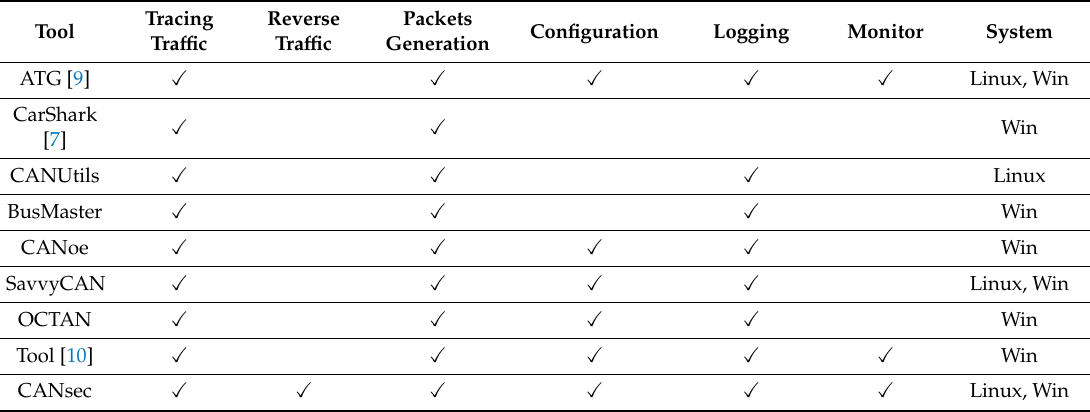
Table 3. Comparison of di ff erent CAN bus